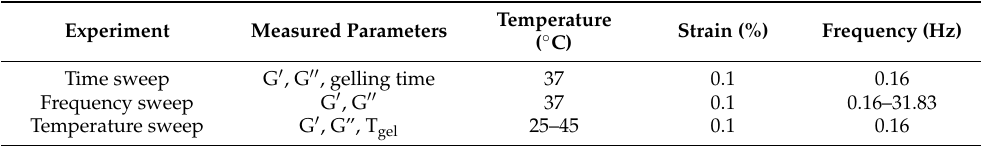
Table 1. Experimental set up of the rheological